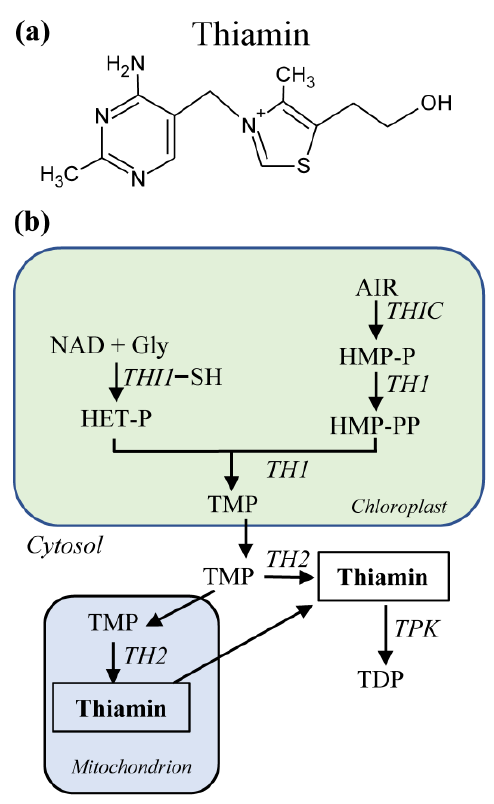
Figure 1. Thiamin biosynthesis in higher plants. ( a ) Chemical structure of thiamin. ( b ) Thiamin biosynthesis requires steps in the chloroplast, cytosol, and the mitochondria. AIR, 5-aminoimidazole ribonucleotide; Gly, glycine; HET-P, 4-methyl-5- β -hydroxyethylthiazole phosphate; HMP- P, 4-amino-2-methyl-5-hydroxymethylpyrimidine phosphate; HMP-PP, 4-amino-2-methyl-5- hydroxymethylpyrimidine diphosphate; TH1, HMP-P kinase/TMP pyrophosphorylase; THI1,